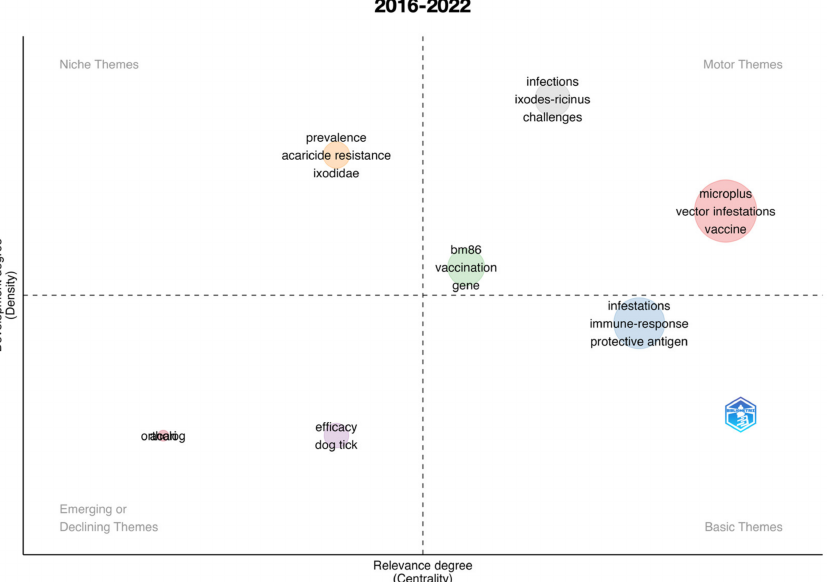
Figure 6. Thematic roles of the documents published on the topic “anti–tick vaccination” in the period